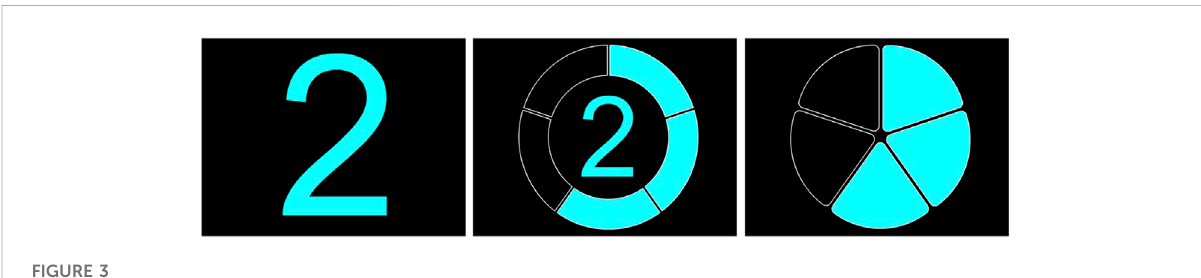
FIGURE 3 eHMI design countdown as applied for the fi eld